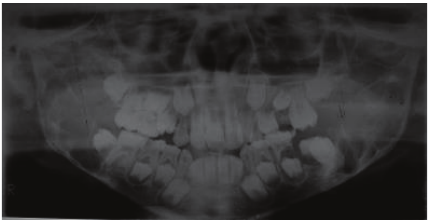
Figure 3: Orthopantomogram showing bilateral multilocular radi- olucencies involving posterior body, ramus of mandible, and condyle typically spared.